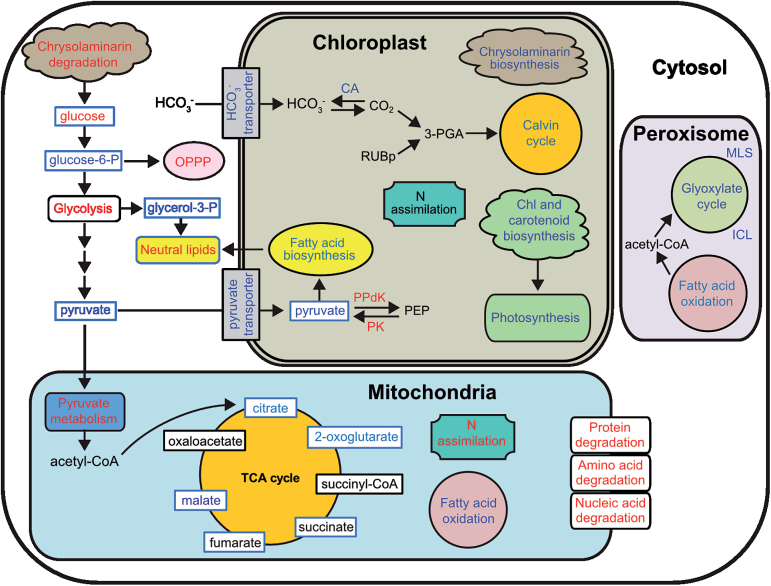
Cellular pathways and processes affected under N deprivation in P. tricornutum. Metabolites detected are indicated by a blue box frame. Red, blue,and black text indicates up-, down-, and no regulation of pathways, genes, or metabolites by N deprivation, respectively. 3-PGA, 3-phosphoglycerate; CA, carbonic anhydrase; ICL, isocitrate lyase; MLS, malate synthase; OPPP, oxidative pentose phosphate pathway; PEP, phosphoenolpyruvate; PK, pyruvate kinase; PPdK, pyruvate orthophosphate dikinase; RuBP, ribulose-1,5-bisphosphate.